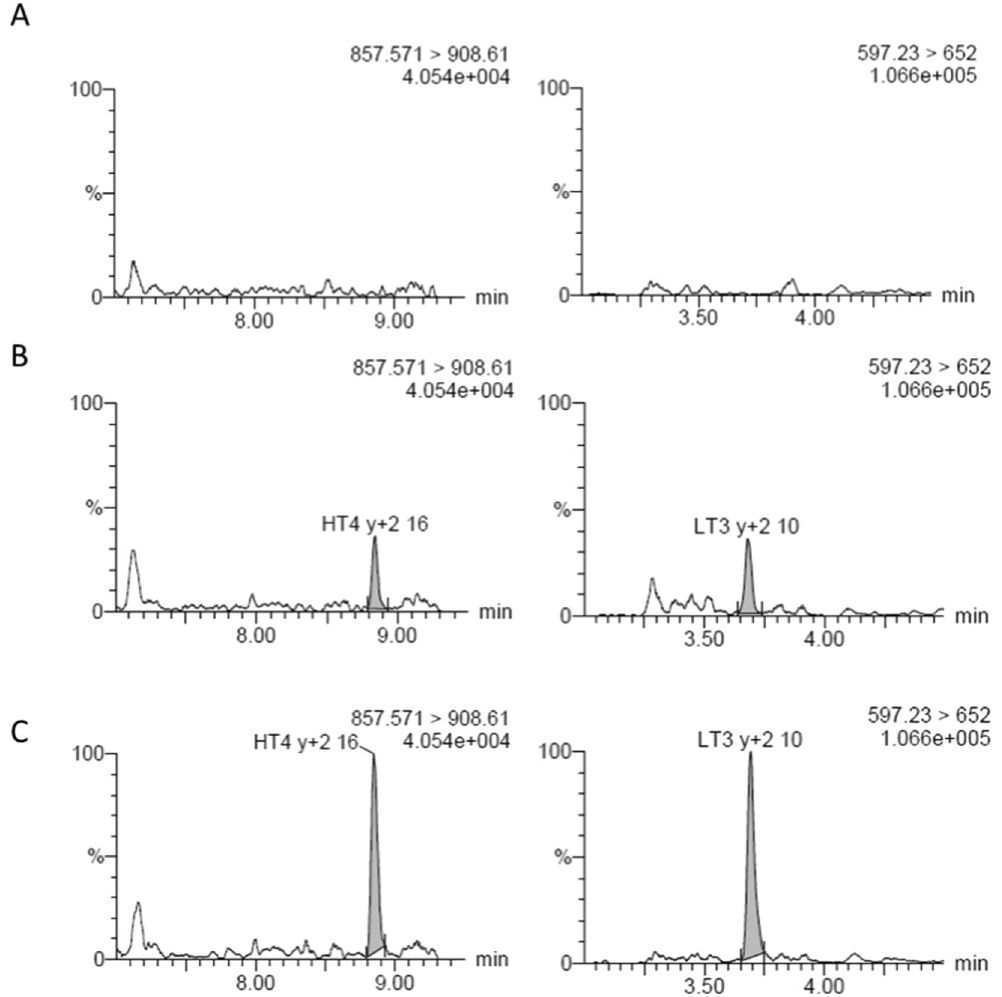
Figure 2. Chromatograms of HT4 (left) and LT3 (right) peptides illustrating signal in blank plasma samples ( A ), at LLOQ ( B ) and from a patient before cetuximab dosing (residual concentration) ( C